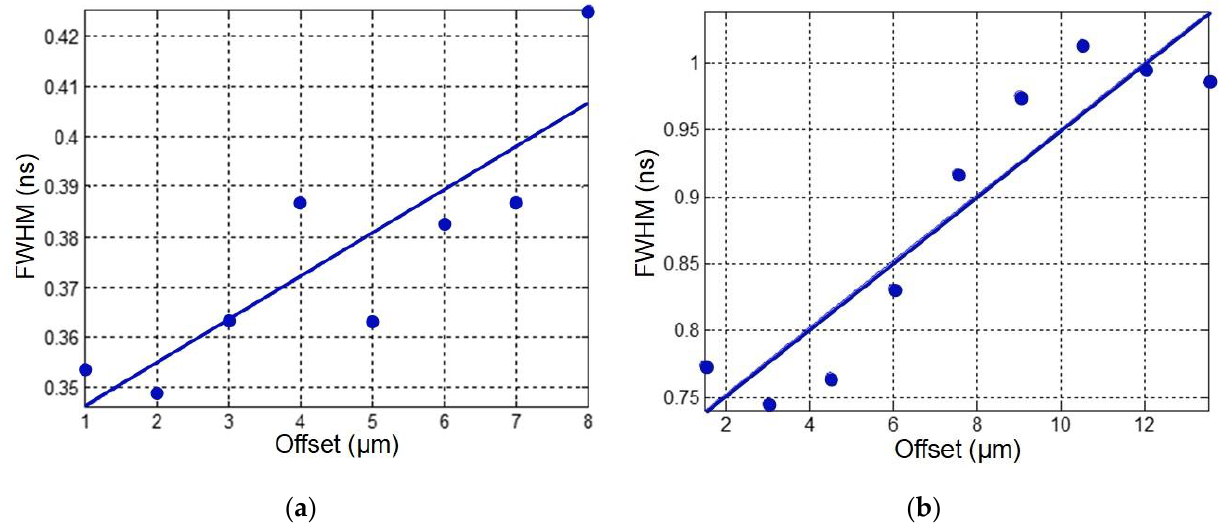
Figure 17. Optical pulse response FWHM dependance on offset: ( a ) 10 revolutions per meter; ( b ) 66 revolutions per meter.